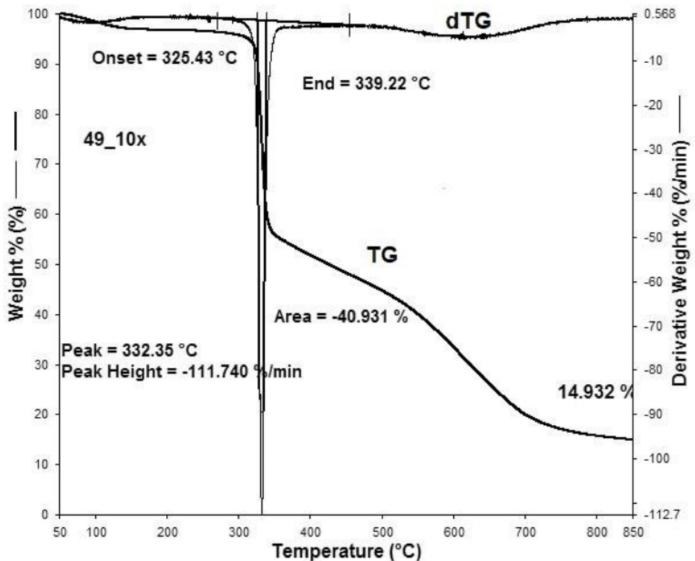
Figure 9. Thermogravimetric analysis of 49_10x sample: TG curve, dTG